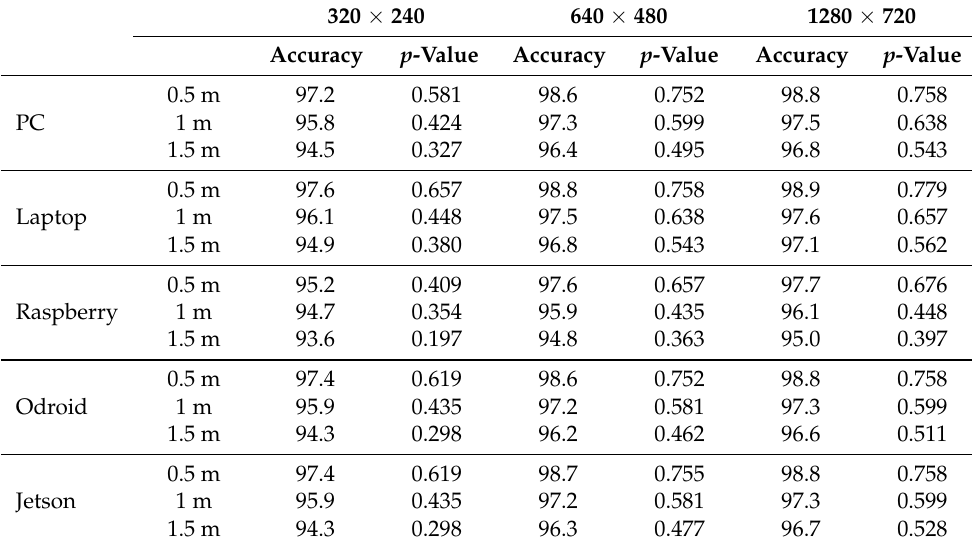
Table 2. Average accuracies and average p -values of the HR estimation at varying distances from the vision sensor and frame resolution.